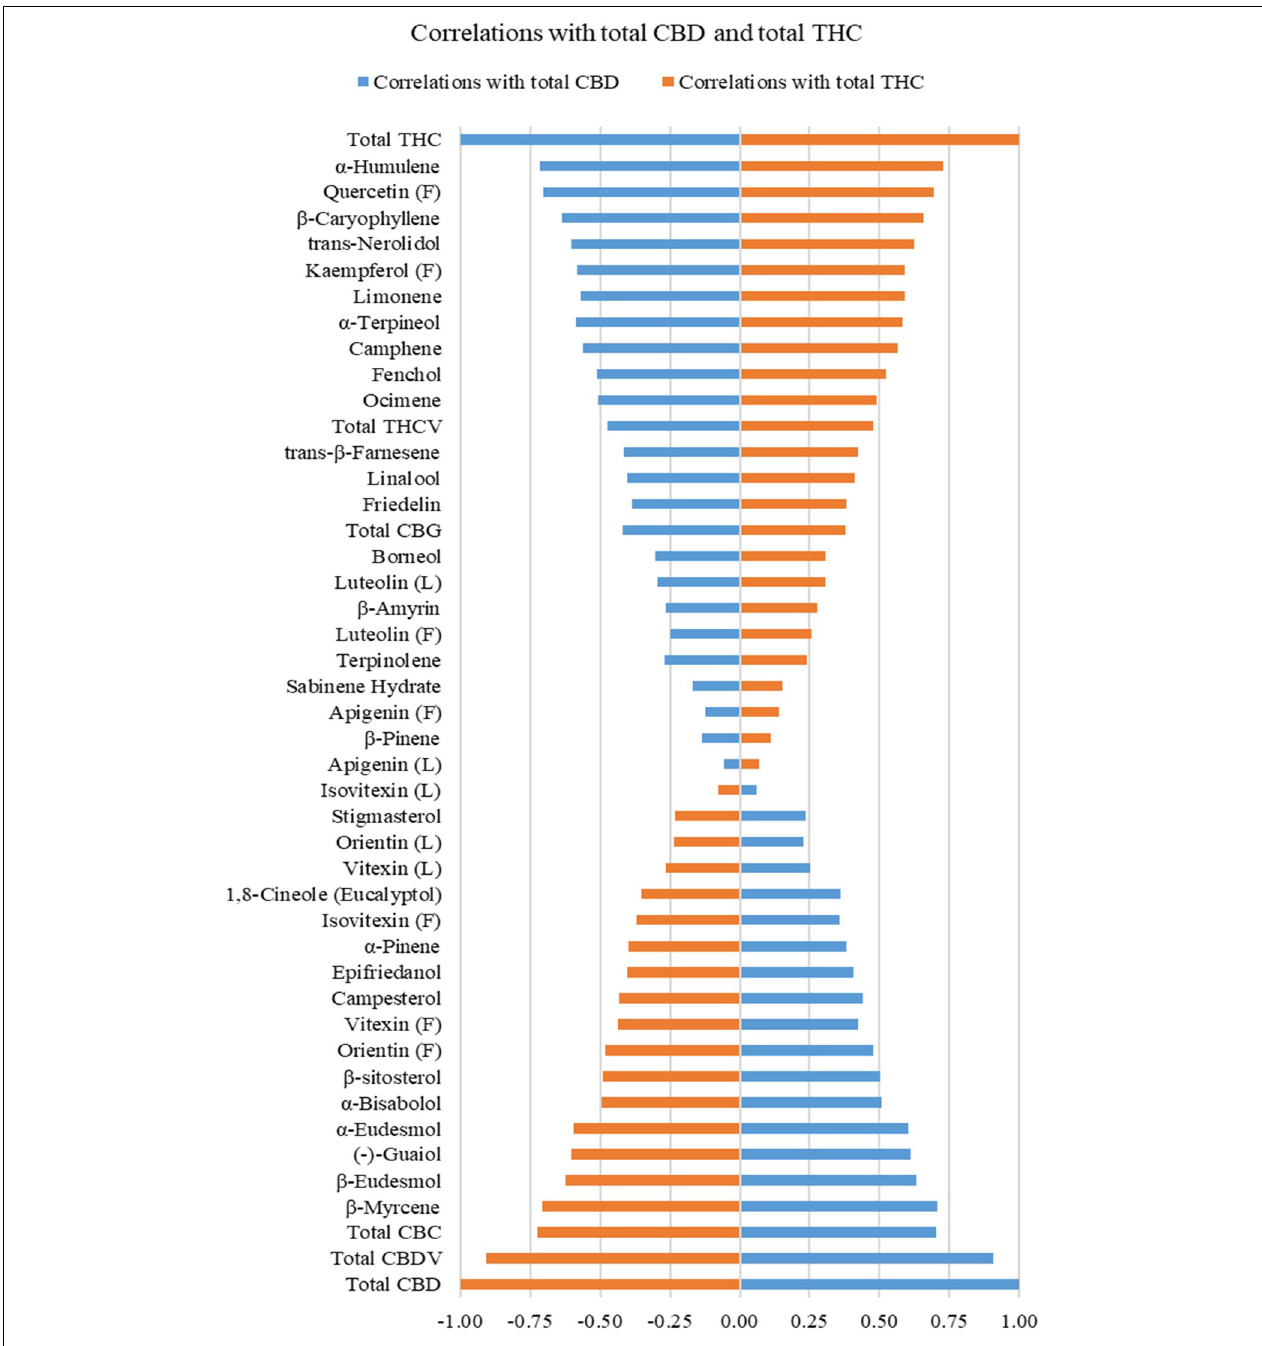
FIGURE 2 | Correlations of total THC and total CBD with cannabinoids (in inflorescences), mono- and sesquiterpenoids (in inflorescences), flavonoids (in inflorescences and leaves), sterols (in roots), and triterpenoids (in roots) on quantifiable compounds using ratios. Flavonoids quantified in inflorescences are labeled (F), and flavonoids in leaf are labeled (L).